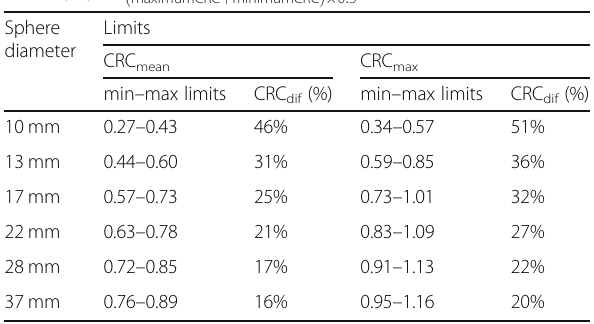
Table 3 CRC mean and CRC max limits for the six phantom spheres as defined by EARL [17]. For each sphere, relative differences between the upper and lower CRC limits were calculated using CRC dif ð % Þ ¼